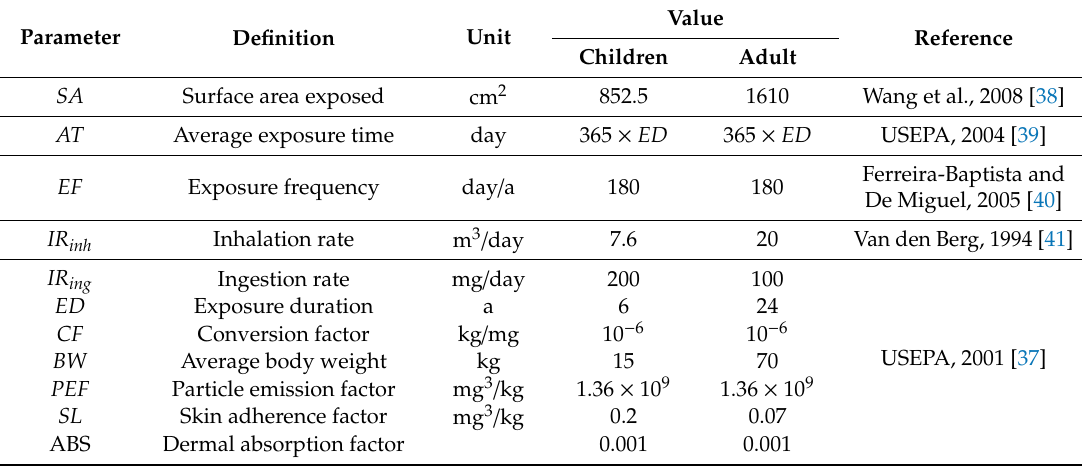
Table 2. Parameters for health risk model of